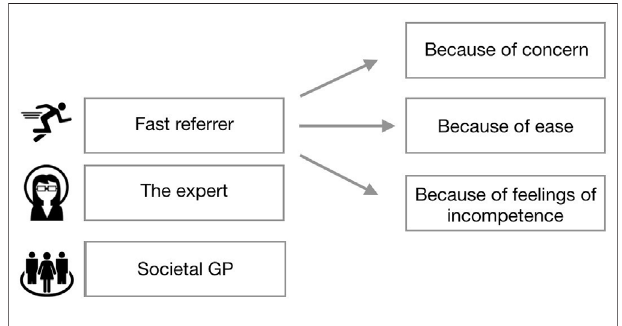
FIGURE 2 | Typology of GPs.